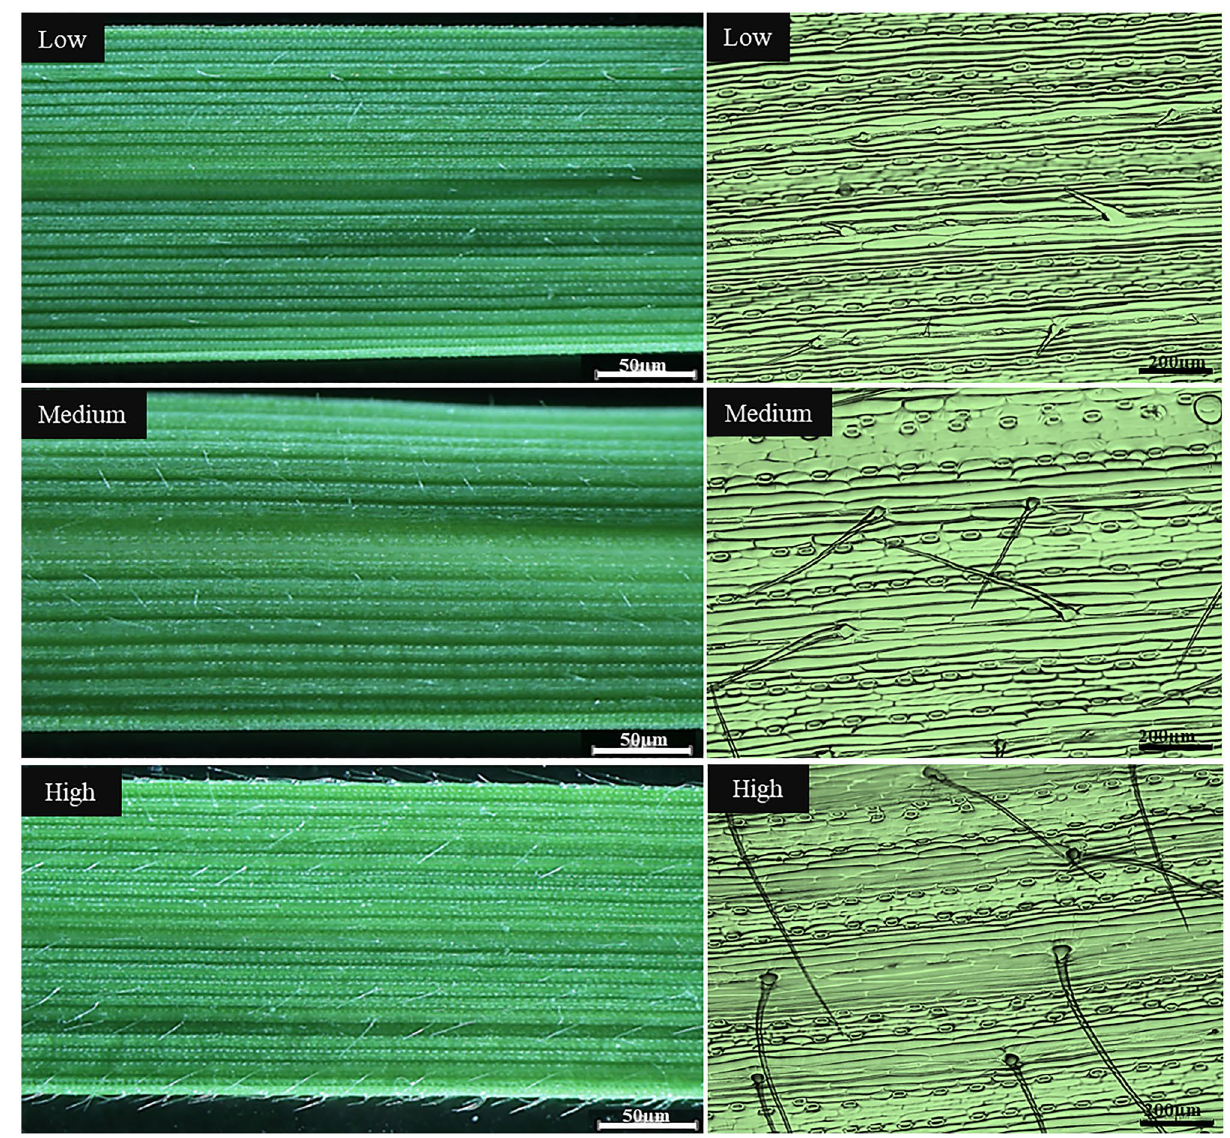
Figure 1. Representative photographs (left side) and scanning microscope photographs (right side) of the leaf adaxial side illustrating the low (1–3), medium (4,5) and high (6,7) leaf density scoring ranges among 293 Aegilops tauschii accessions.